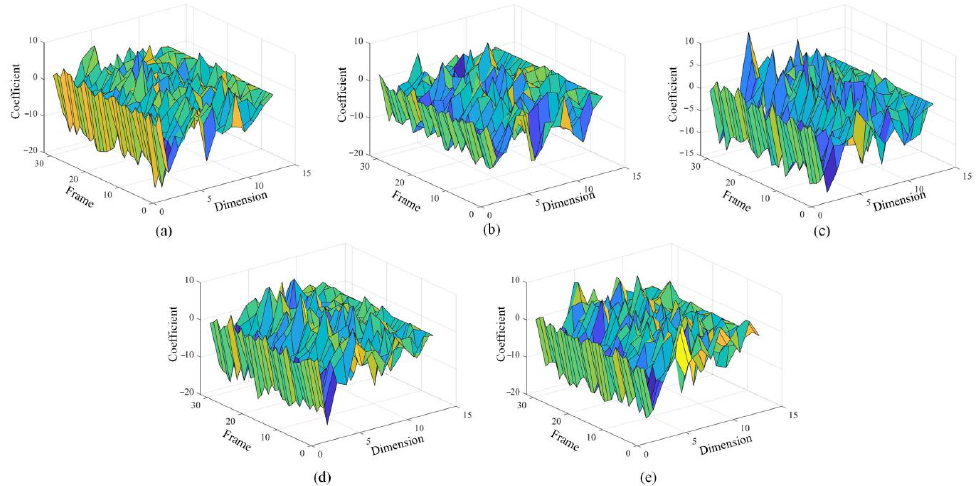
Figure 10. Comparison of MFCC characteristics in different states ( a ) normal state; ( b ) blocked air inlet; ( c ) the first cylinder misfire; ( d ) the third cylinder misfire; ( e ) the sixth cylinder misfire.